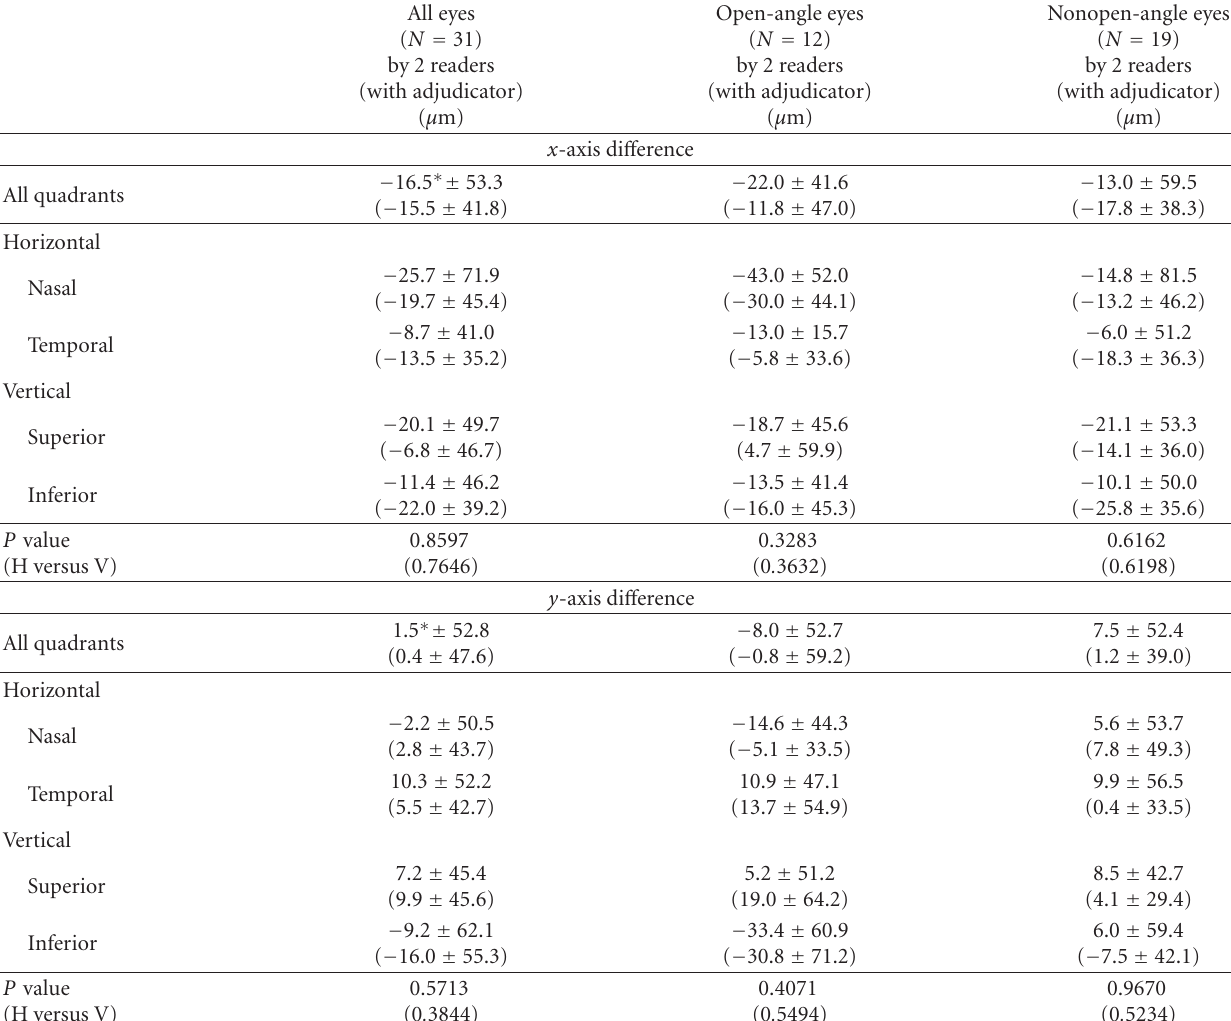
Table 2: Mean ( ± standard deviation) di ff erences ( μ m) in scleral spur landmark